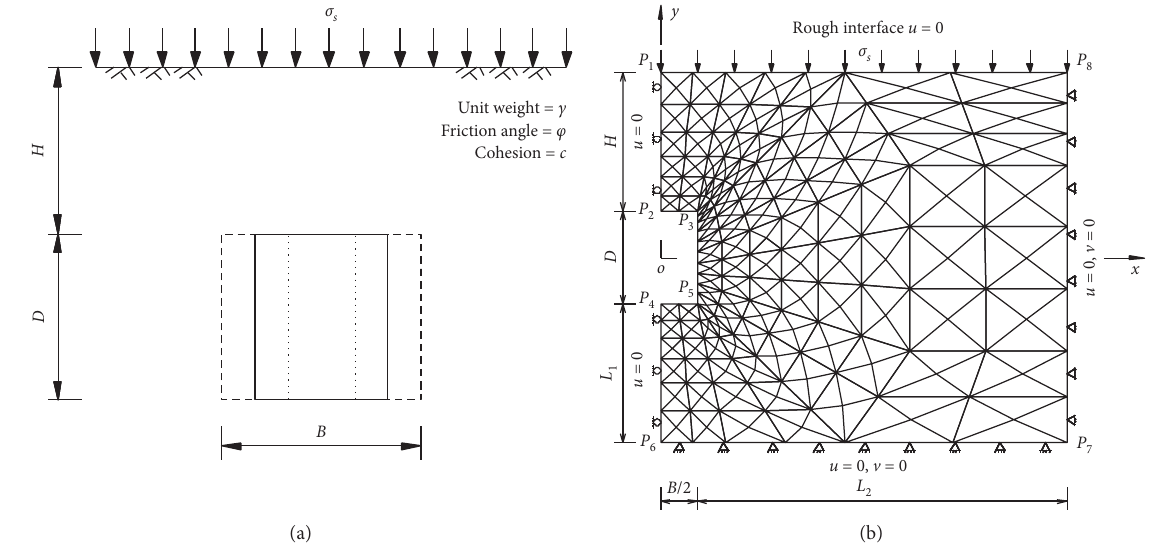
Figure 1: Analysis model for a rectangular tunnel. (a) Problem definition. (b) Mesh divisions for the case with B / D � 0.75 and H / D �